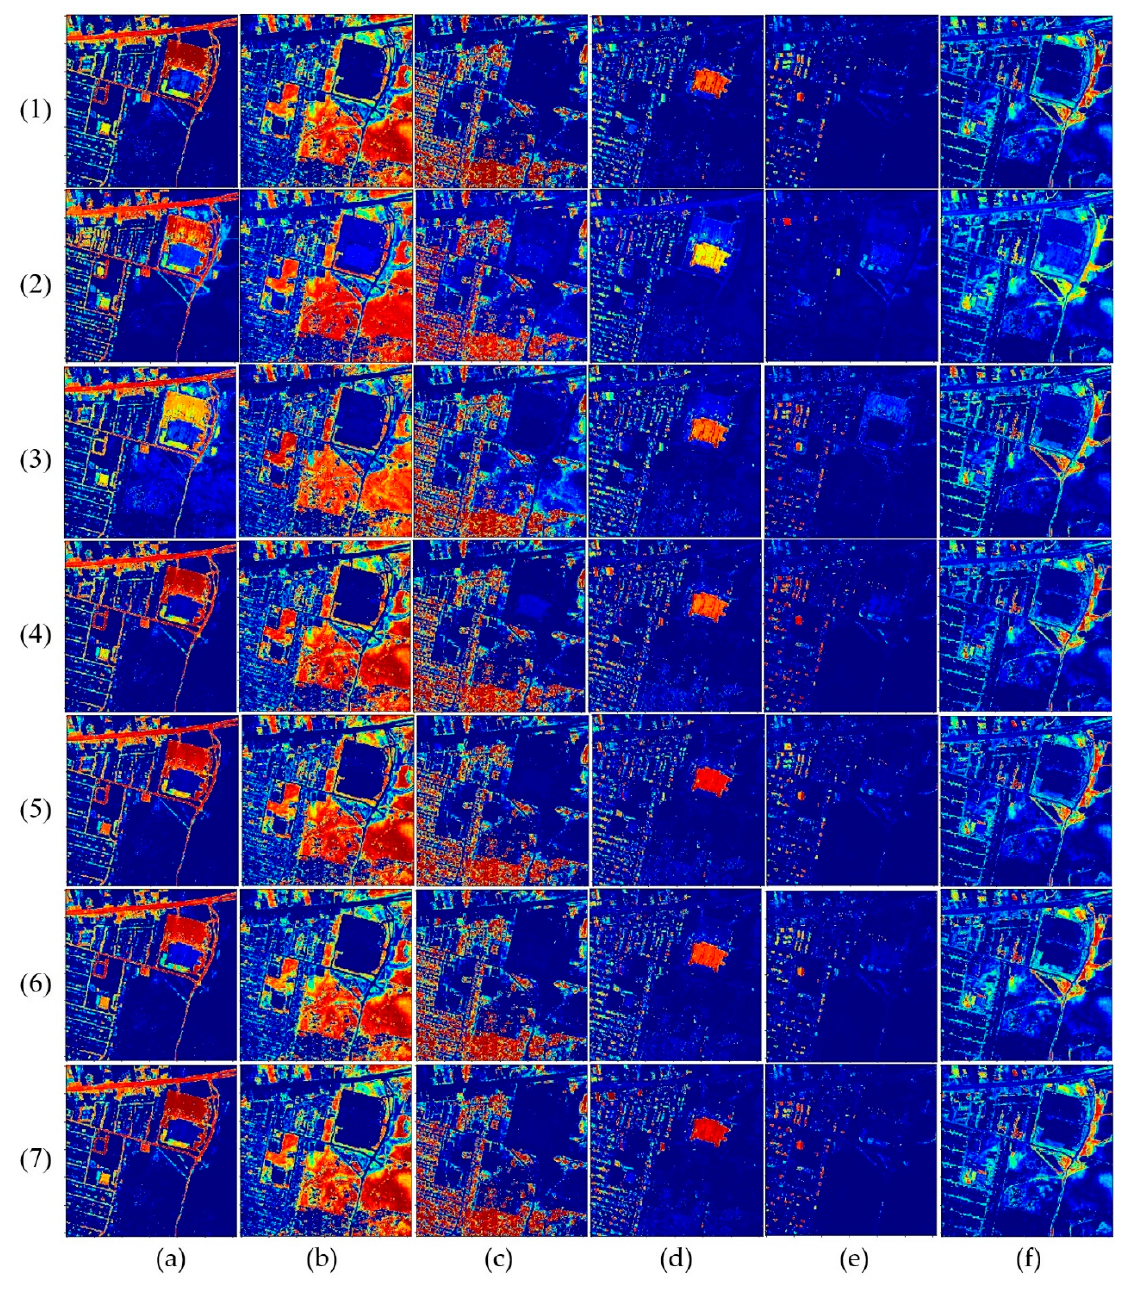
Figure 5. Ground truth and estimated abundance maps of its endmembers using the proposed method and contrastive methods with a 5% training ratio. ( 1 ) Ground truth; ( 2 ) CNN; ( 3 ) STFHU; ( 4 ) STCNN; (4) ResNet; ( 5 ) AResN; ( 6 ) RNST; ( 7 ) ARNST; ( a ) Asphalt Road; ( b ) Grass; ( c )Tree; ( d )Roof; ( e )Metal; and (f) Dirt.